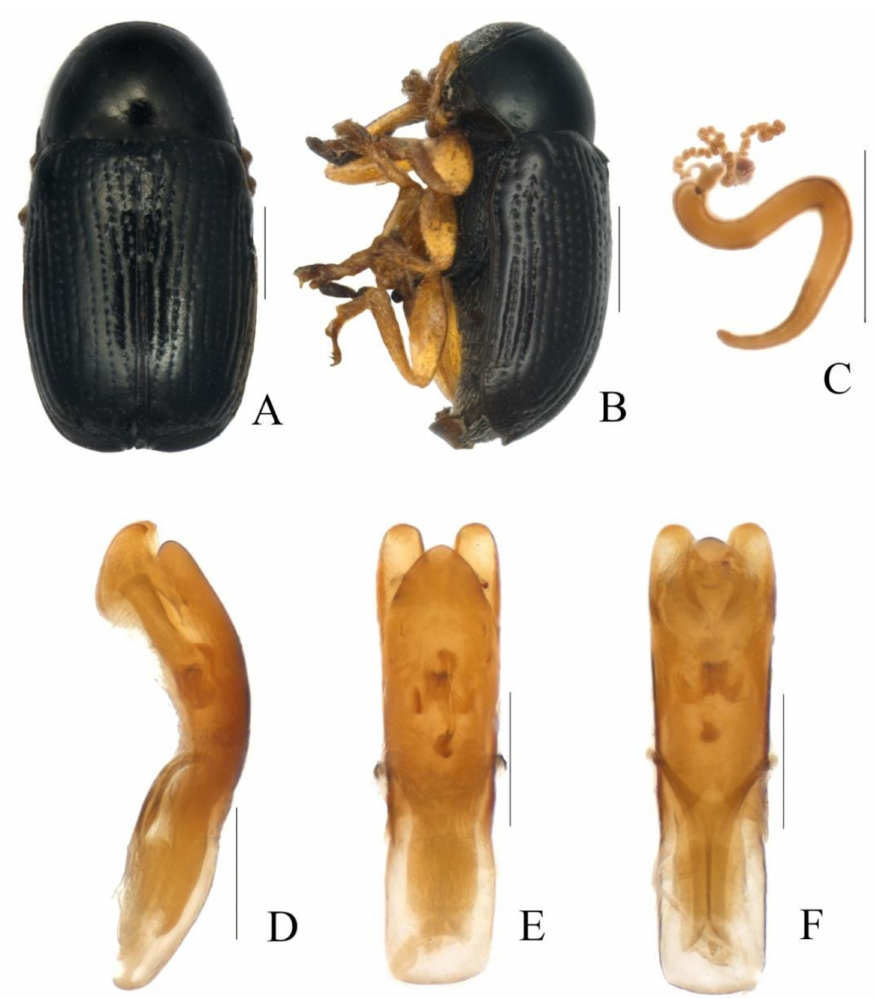
Figure 8. Cryptocephalus ( Burlinius ) glabrelegantulus Duan & Zhou, sp. nov.: ( A ) habitus; ( B ) lateral view of habitus; ( C ) spermatheca; ( D ) lateral view of aedeagus; ( E ) dorsal view of aedeagus; ( F ) ven- tral view of aedeagus. (Scale bars: ( A , B ) = 0.5 mm, ( C – F ) = 0.2 mm.) (( A , B , D – F ): holotype, male; ( C ): paratype, female).